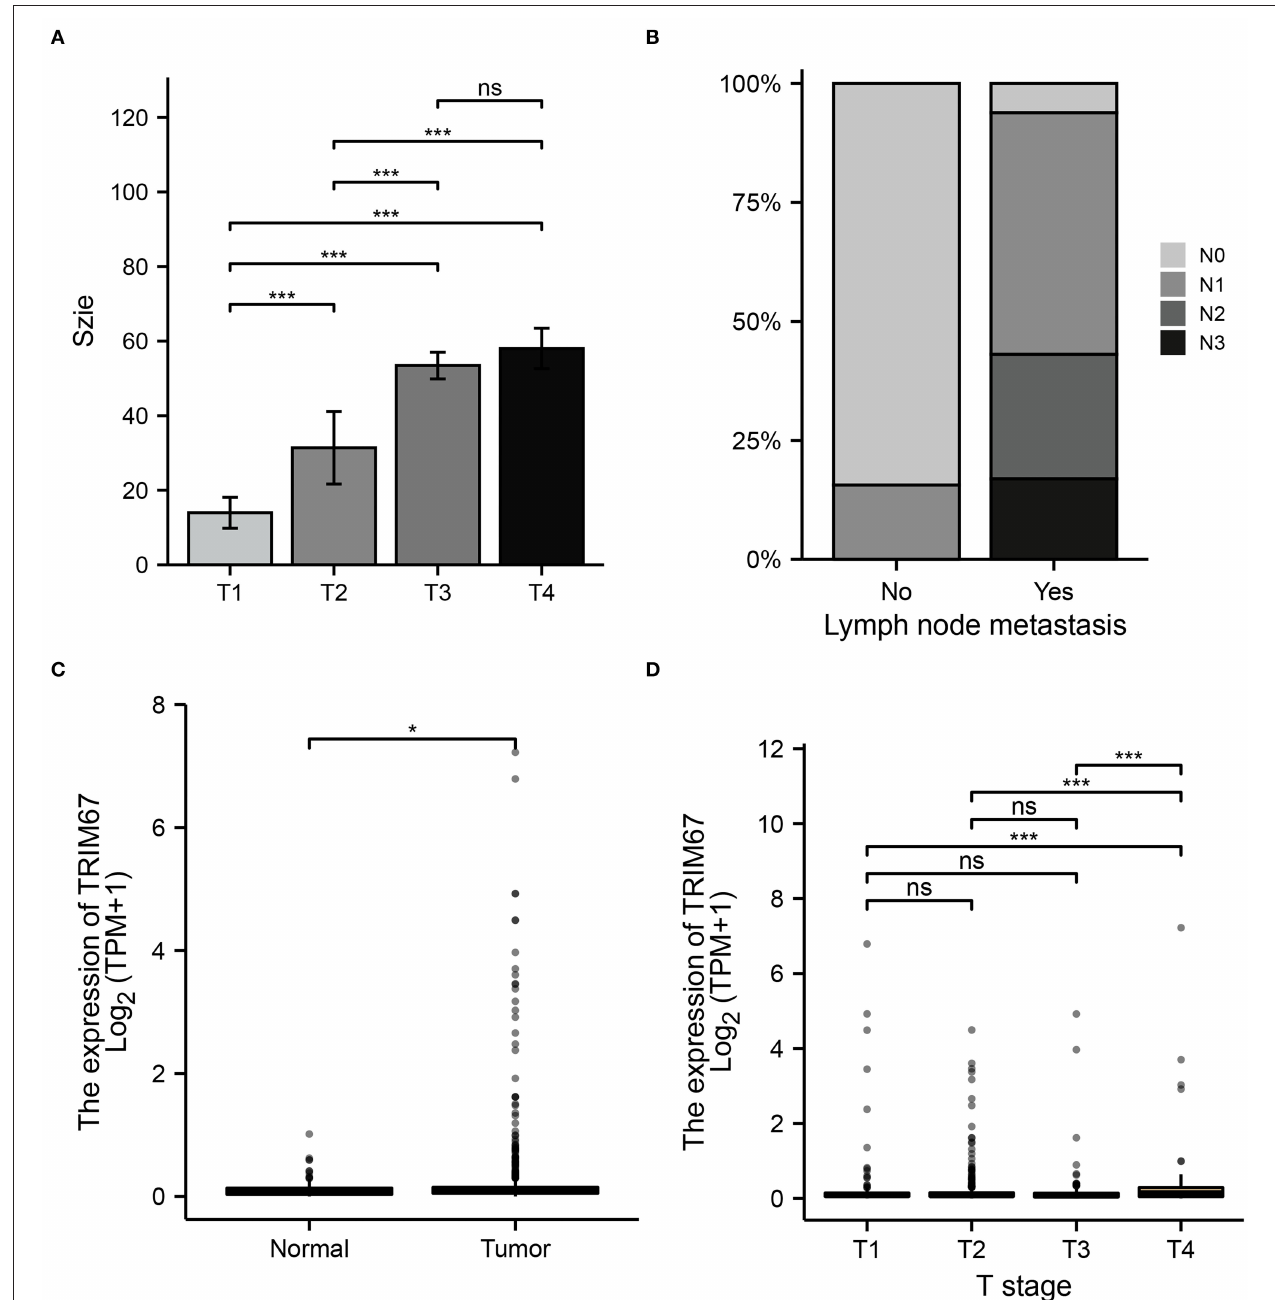
FIGURE 5 | Relationship between preoperative ultrasonography and TRIM67 and postoperative pathological features. (A) The bar chart shows a correlation between the T-grading of the tumor and the size of the tumor as measured using preoperative US; (B) There was a correlation between US-predicted lymph node metastasis and the N grade of the tumor; (C) There were differences in TRIM67 expression between normal and tumor tissues; (D) There were differences in TRIM67 expression between different tumor